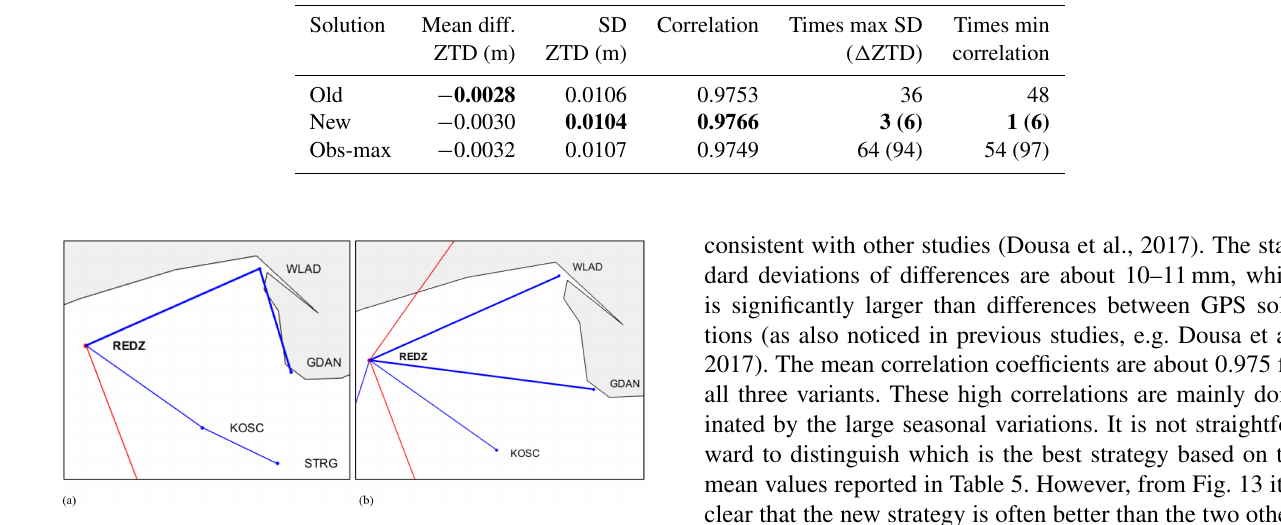
Table 5. Mean statistics of ZTD differences and correlations between GPS and ERA-Interim computed over 103 common ASG-EUPOS stations. Column 5 (respectively 6) gives the number of stations for which the standard deviation of ZTD difference (respectively correlation) is maximum (respectively minimal) among the three solutions. The numbers in brackets are for the comparison of new and obs-max only. The best values are indicated in bold.